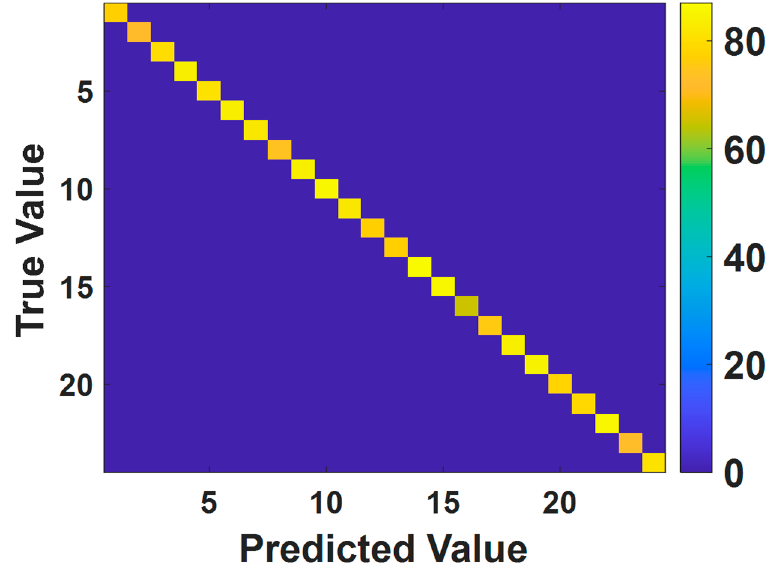
Figure 5. The confusion matrix of the testing set.